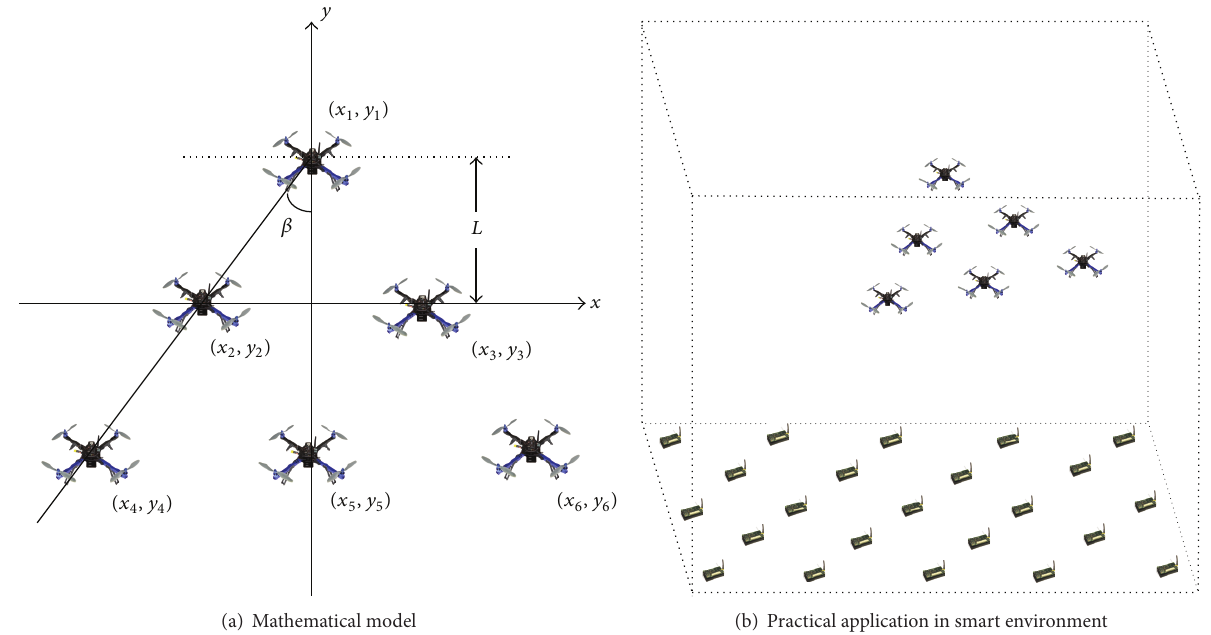
Figure 9: The model of formation control for quadrotor helicopters under the condition of different height.